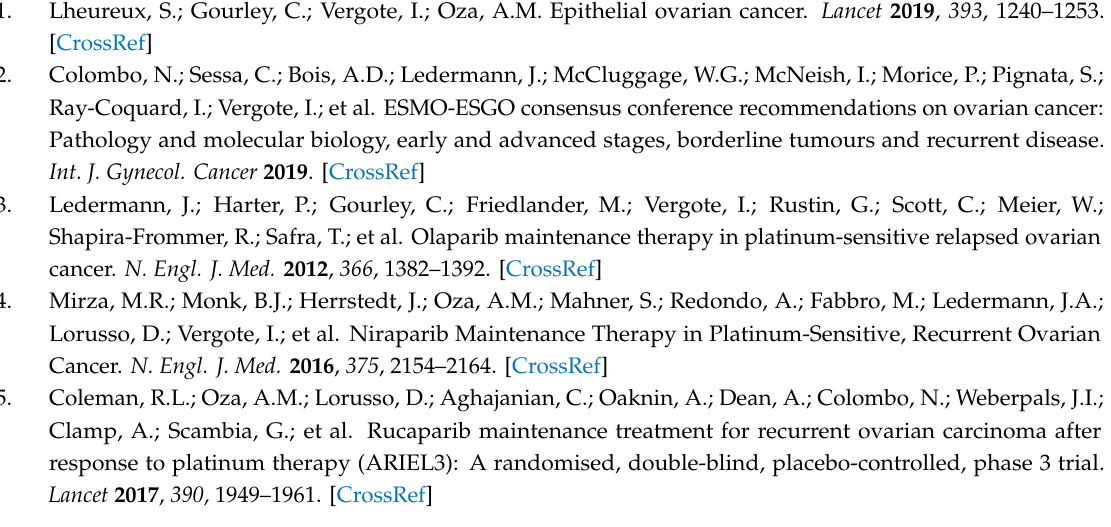
Figure S1: Validation of the RECAP test using fresh and cryopreserved tumor specimens, Figure S2: Flowchart illustrating inclusion criteria for RECAP specimens and take-rate, Figure S3: Microscopy illustration of HRP and HRD solid and ascites ovarian tumor specimens classified by the RECAP test, Figure S4: Timeline treatment procedure EOC patients, Figure S5: Flowchart illustrating patient inclusion for comparison of RECAP scores with therapy response, Table S1: Identification of HR-deficient tumors by functional and genomic analyses, Table S2: Estimated workload of BRCA next-generation sequencing gene panel testing versus the RECAP test, Table S3: Estimated cost prices for a BRCA next-generation sequencing gene panel versus the RECAP test, Table S4: Excluded tumor specimens based on tissue quality, p53 status or the RECAP test, Table S5: Pathogenic variants in BRCA1 and BRCA2 identified in HR-deficient ovarian carcinomas and Table S6: Extended clinicopathological characteristics of the ovarian cohort stratified for homologous recombination repair capacity as determined by the RECAP